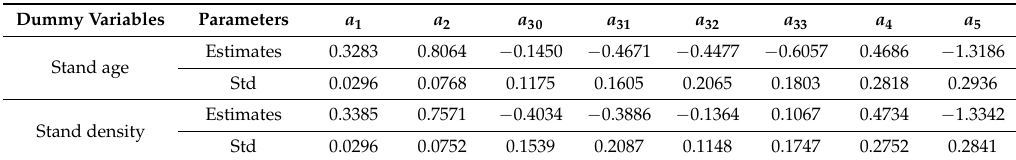
Table 4. Estimates for the parameters of the dummy variable regression model for the stand age and stand density (Equations (10) and (11)).